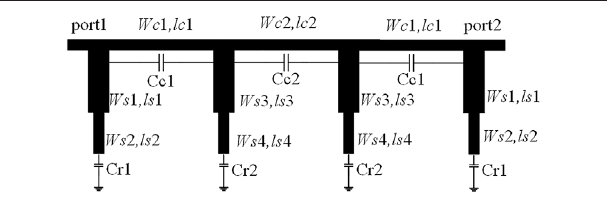
FIGURE 3 | The schematic of the designed TLPF.